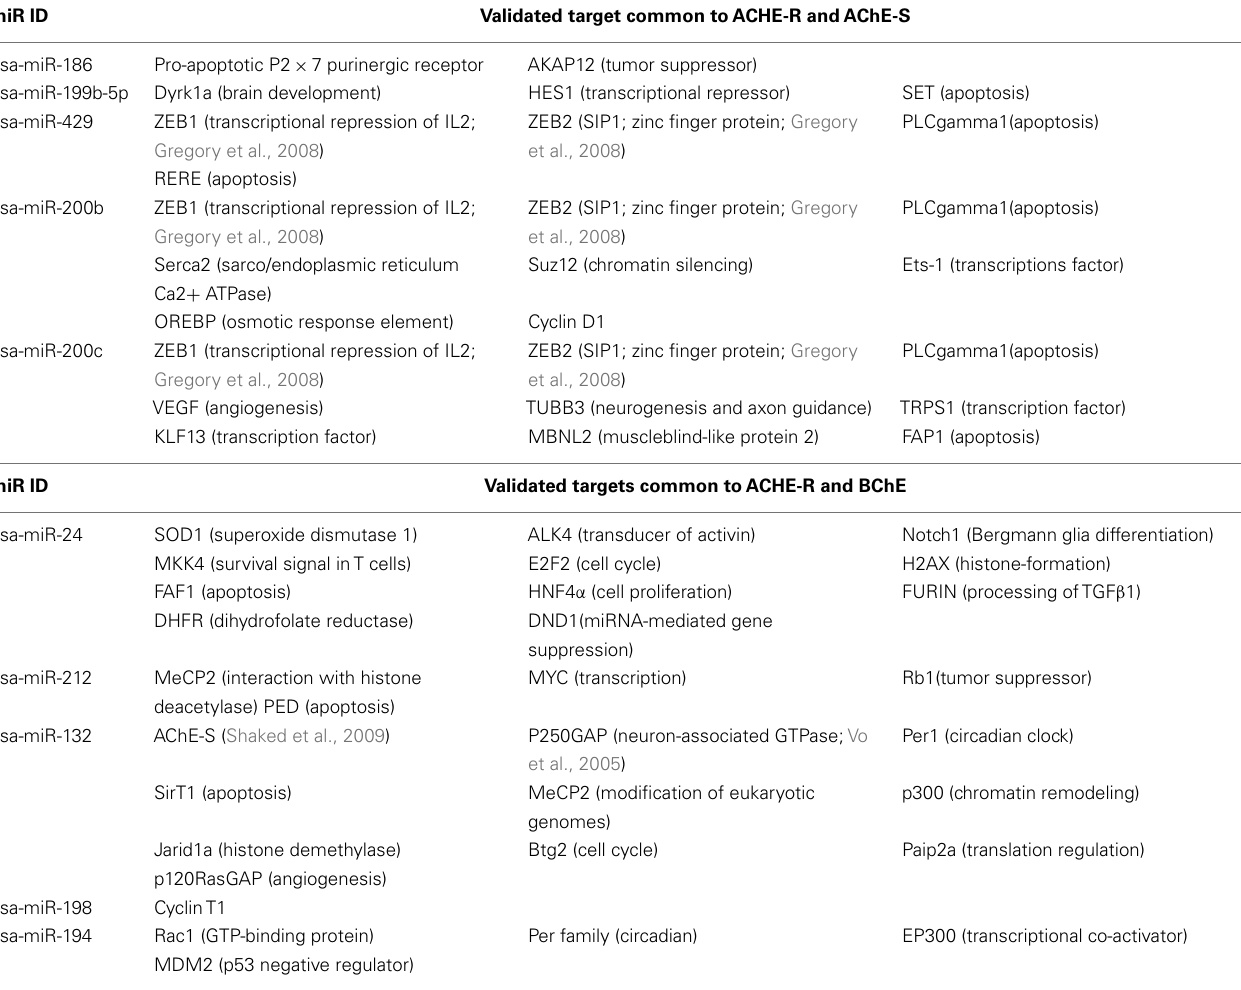
Table 4 |Additional targets of ChE-targeting miRs (common to more than one ChE). miR